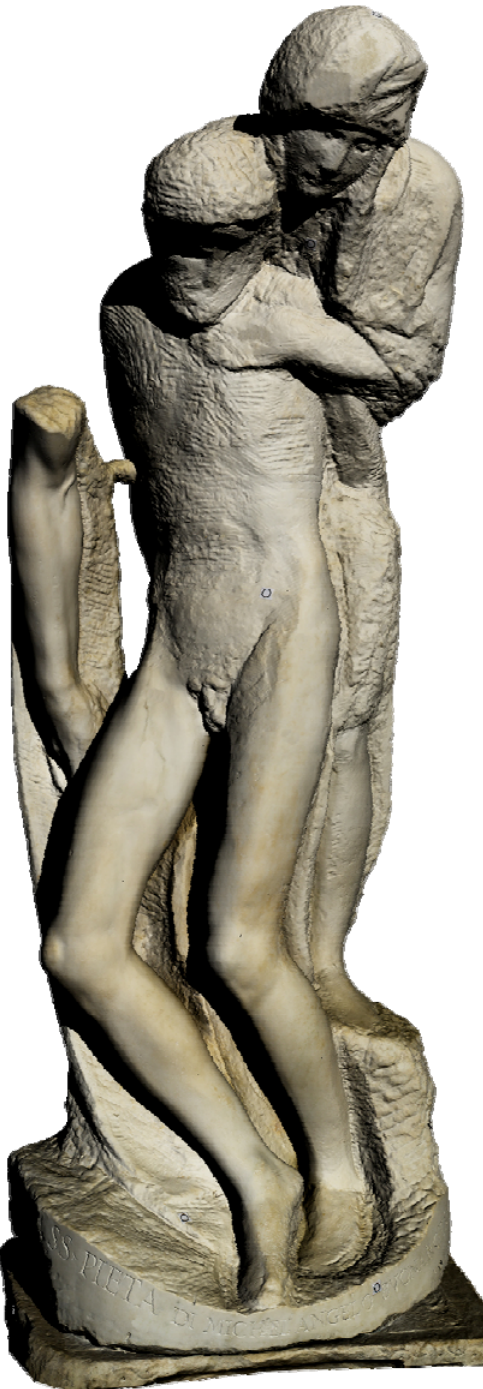
Figure 14. The final hybrid 3D model with 1:1 high-resolution texture